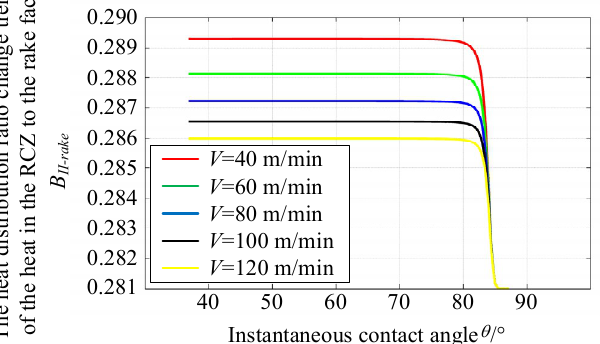
Figure 18. Heat distribution ratio of the heat source to the rake face in the RCZ at different milling speeds ( Ap = 10 mm).